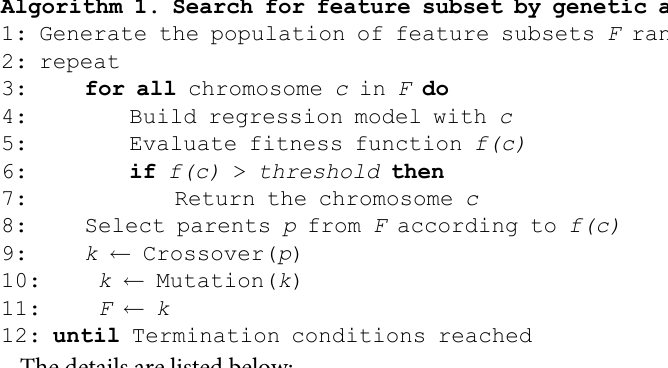
Algorithm 1 . Search for feature subset by genetic algorithm.